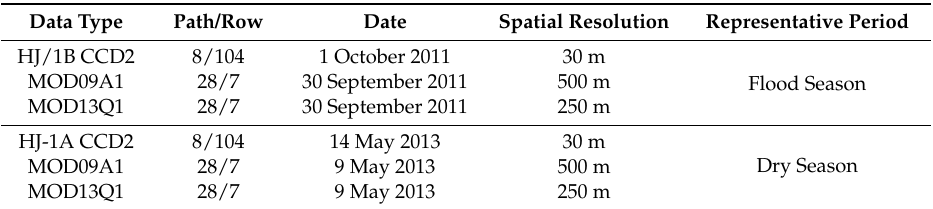
Table 1. Basic Information on the selected remote sensing